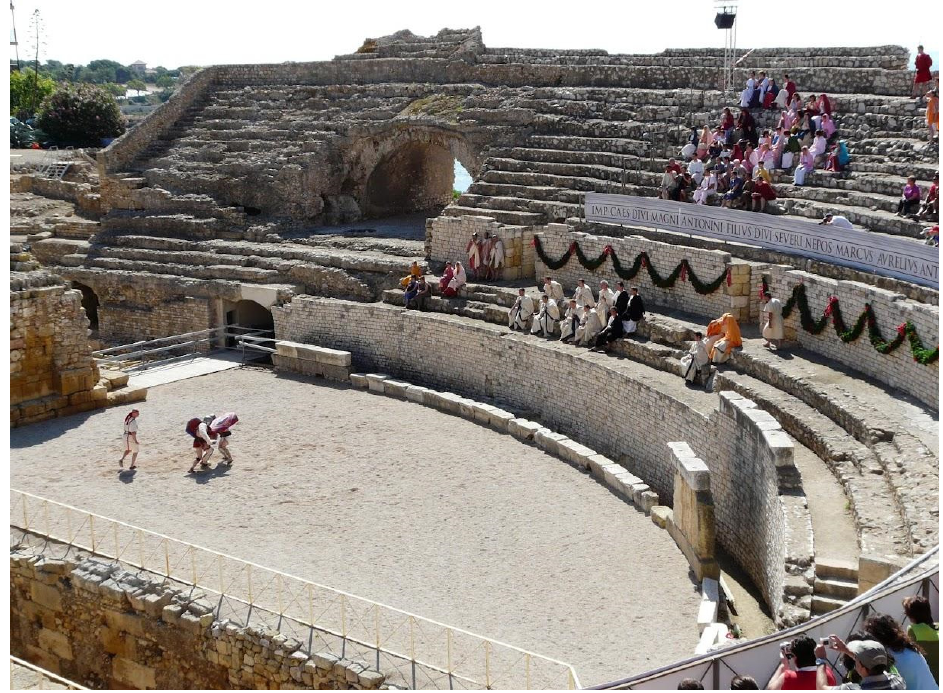
Figure 2. Tarraco reenactment, Spain.